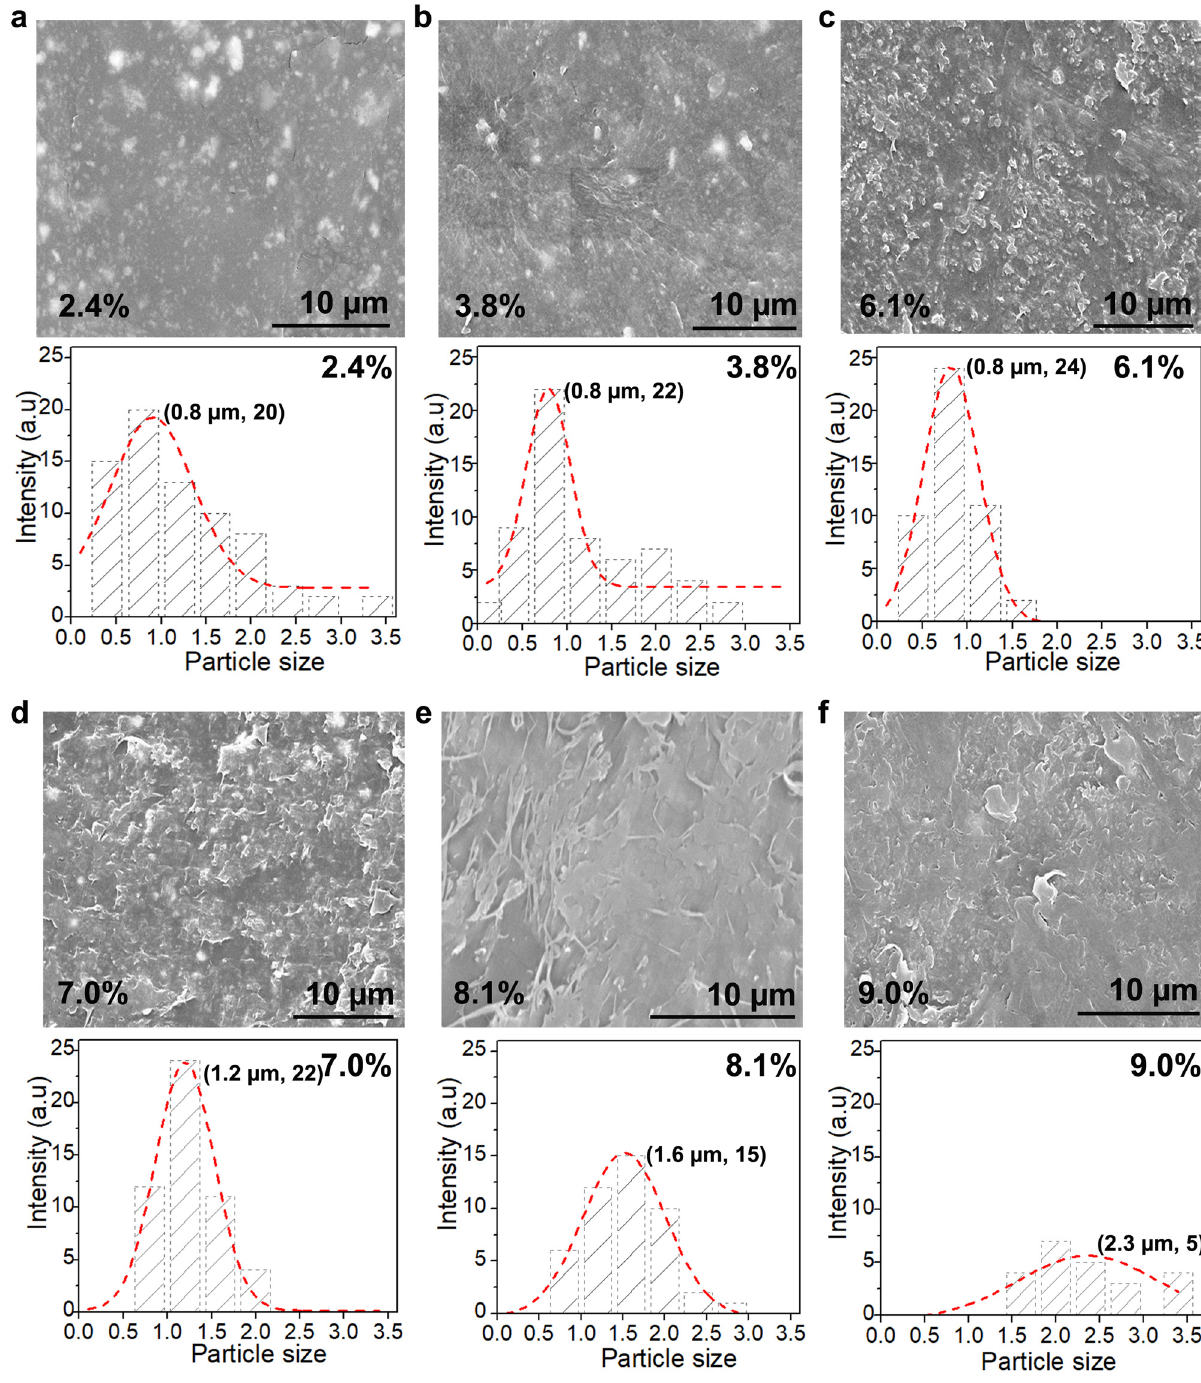
Figure 2: The surface morphology and ZnO NP ( 4% ) size distributions of the fi lms dissolved in the di ff erent mass fractions of LDPE. ( a ) 2.4 wt%, ( b ) 3.8 wt%, ( c ) 6.10 wt%, ( d ) 7.0 wt%, ( e ) 8.1 wt%, and ( f ) 9.0 wt% of LDPE in